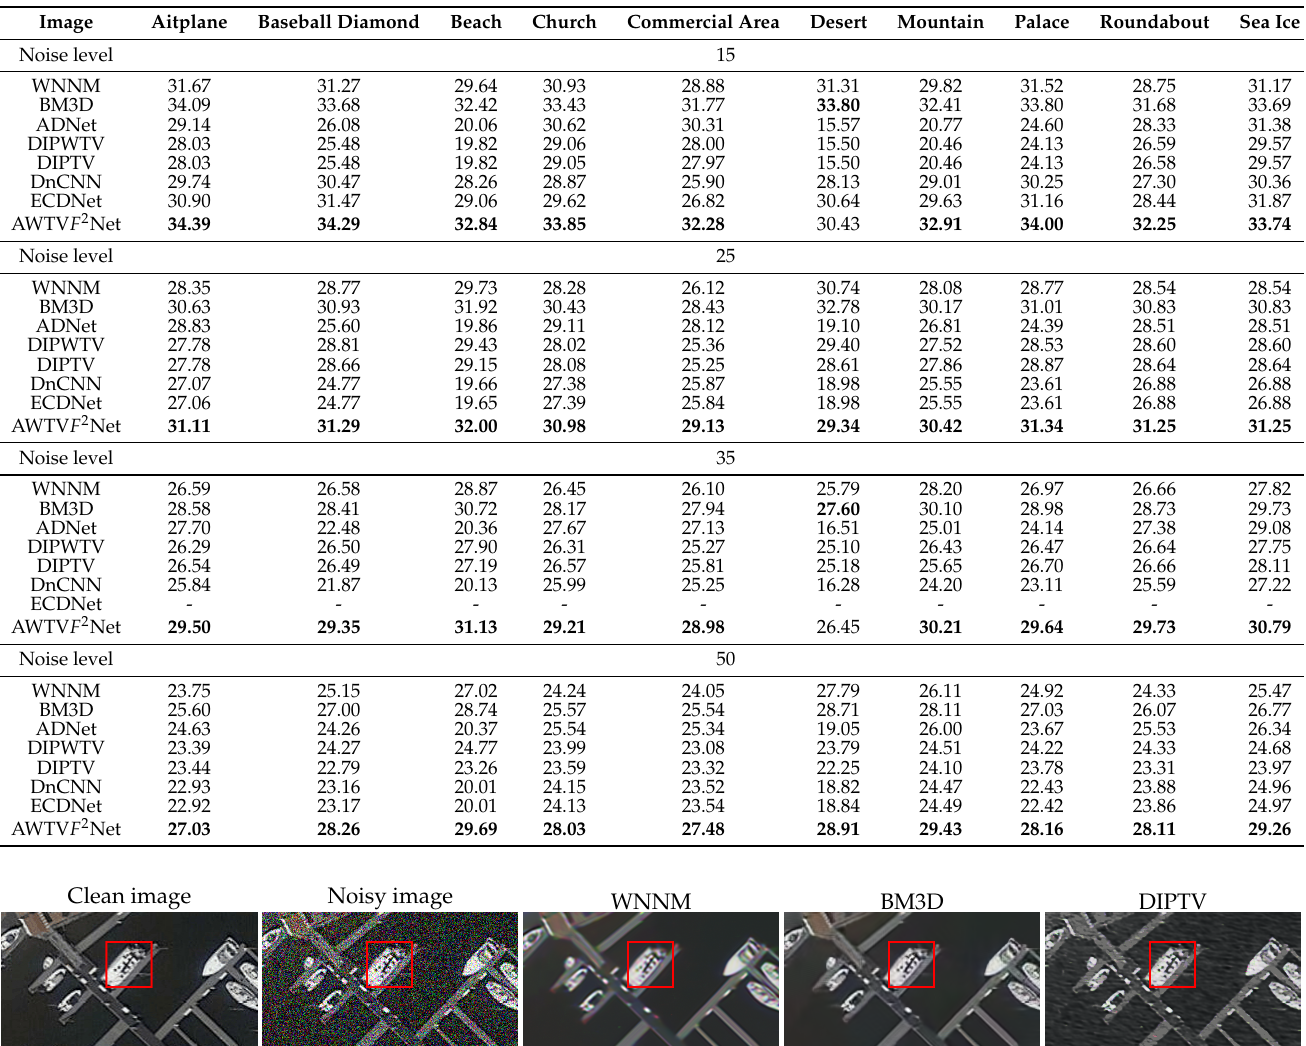
Table 2. PSNR comparisons of all classes’ images in the NWPU dataset. The bold values denote the best results.